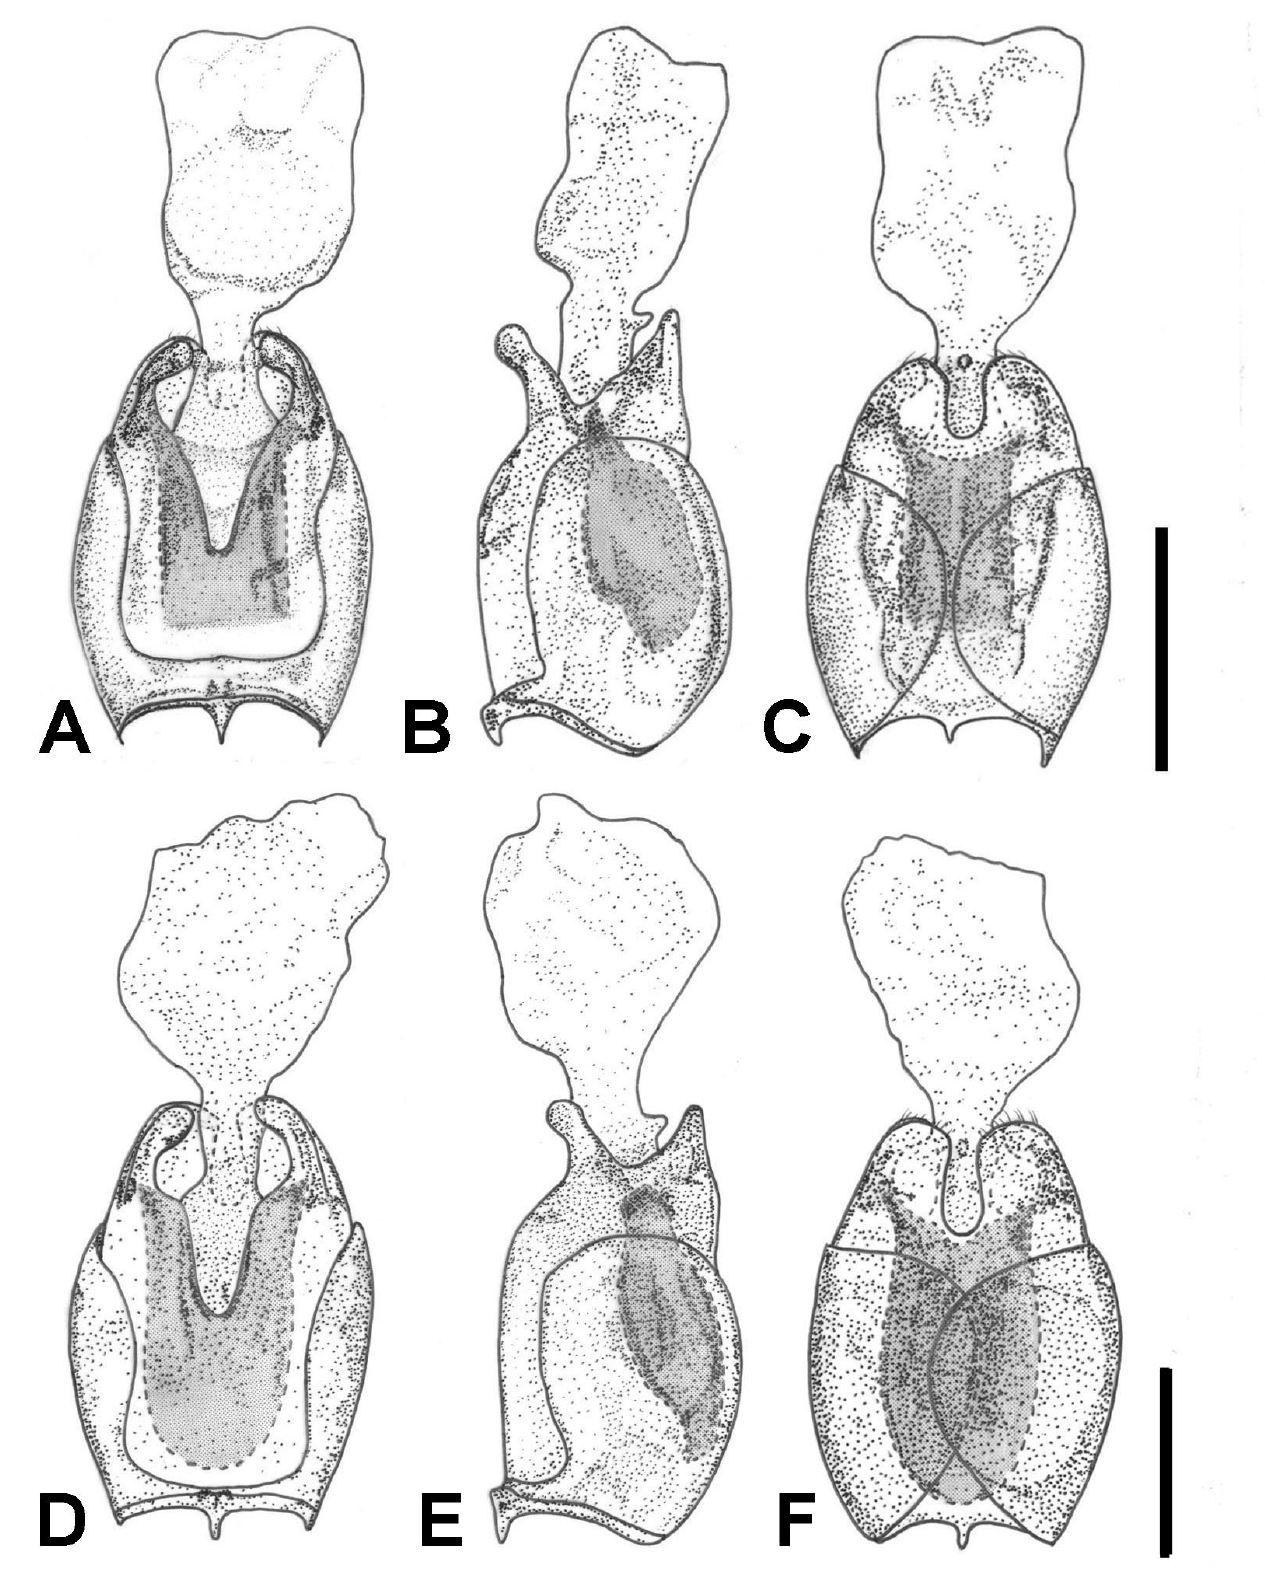
Fig. 5. Aedeagus. A–C . Lycocerus evangelium Hsiao & Okushima sp. nov. D–F . L. kintaroi Hsiao & Okushima sp. nov. A, D. Ventral view. B, E. Lateral view. C, F. Dorsal view. Scale bars: 0.5